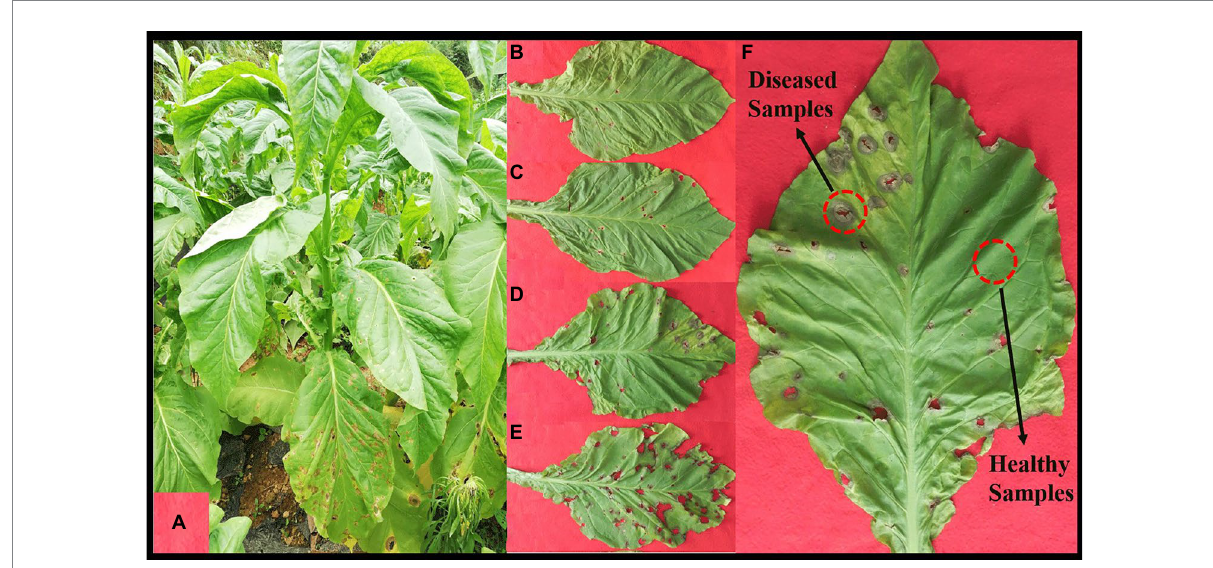
FIGURE 1 Whole plant (A) and leaves displaying disease severity at (B) S1, (C) S5, (D) S7, and (E) S9, respectively. (F) , sampling parts display of diseased and healthy samples on tobacco